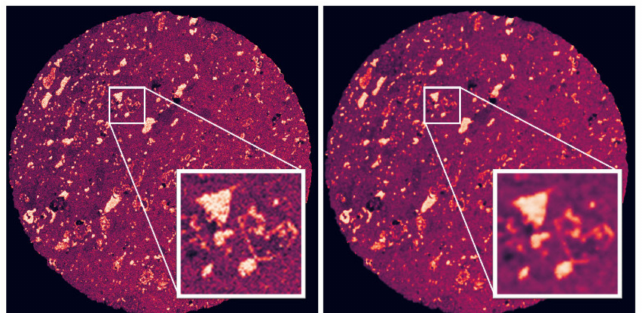
Figure 4. ( Left ) Raw µ XRF map of Na, where the higher intensities indicate higher concentrations of Na. ( Right ) µ XRF map of Na with bilateral filtering applied. The bilateral filtering reduces noise while preserving the edges, which is important in identifying homogenous grains and defining the interface between